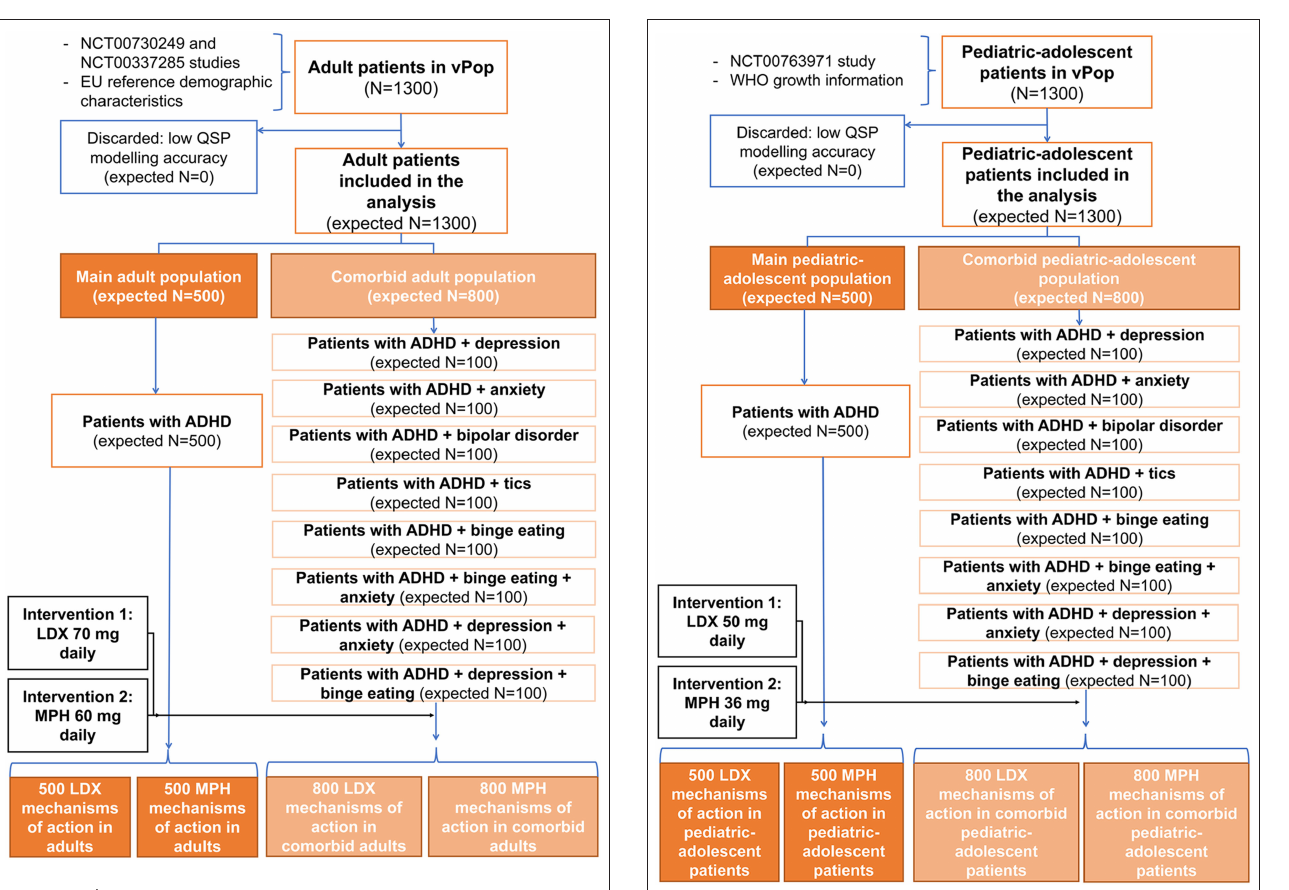
FIGURE 4 | Comorbidities distribution and treatment allocation in the pediatric-adolescent virtual population. ADHD, Attention-deficit/hyperactivity disorder; LDX, Lisdexamfetamine; MPH, Methylphenidate; QSP, Quantitative systems biology; vPOP, Virtual